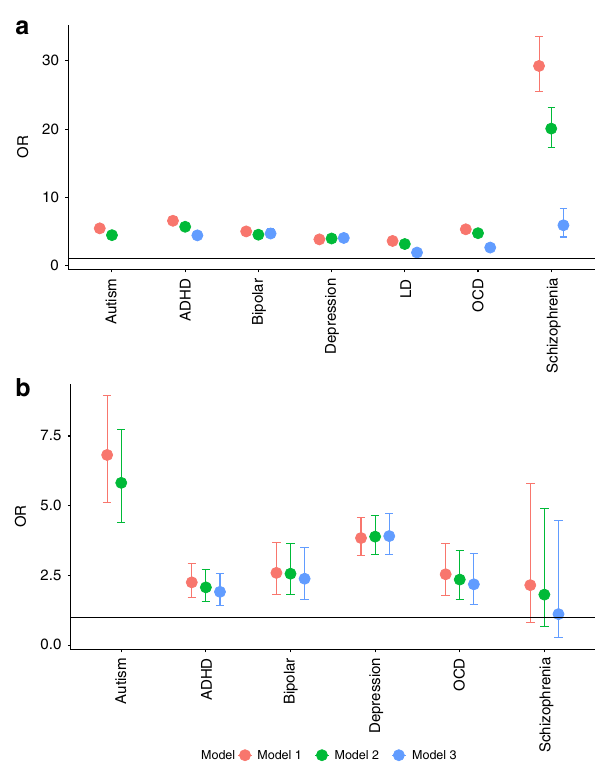
Fig. 4 ORs and 95% CIs for other neurodevelopmental and psychiatric conditions in transgender and gender-diverse individuals compared to cisgender individuals. a This fi gure provides the Odds Ratios (ORs, point) and 95% CIs for diagnosis of autism and six other neurodevelopmental and psychiatric conditions in transgender and gender-diverse individuals compared to cisgender individuals in the C4 dataset ( N = 514,100). We did not employ Model 3 for autism as it was conducted after excluding autistic individuals in the dataset. ORs have been calculated using three models (see Methods). ADHD = Attention-De fi cit/Hyperactivity Disorder; OCD = Obsessive-Compulsive Disorder; LD = Learning Disorder. b This fi gure provides the same, but for the MU dataset ( N = 85,670). Information on LD was not available in the MU dataset. The y-axis is on a different scale from the panel